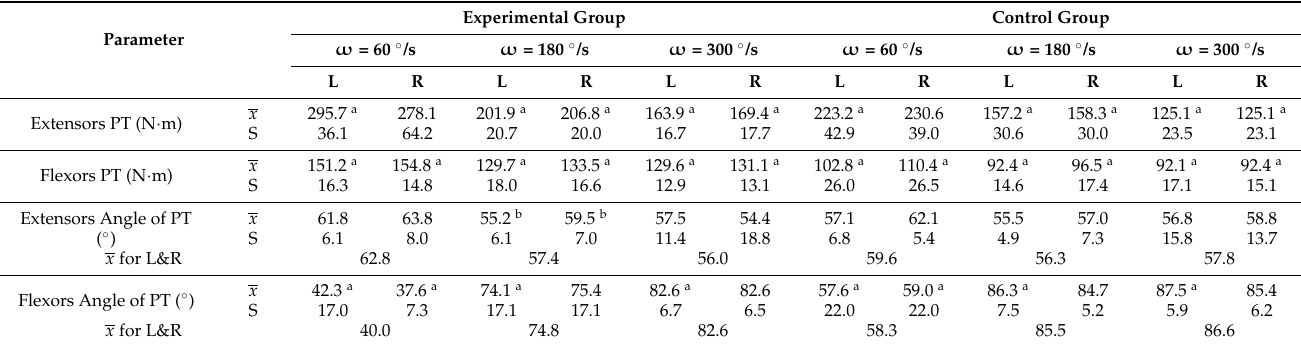
Table 1. Peak torque of the knee joint extensors and flexors obtained during isokinetic tests with concentric movements (mean ± s) and joint angles at which the peak torque was obtained during these tests (mean ± s). Experimental Group Control Parameter